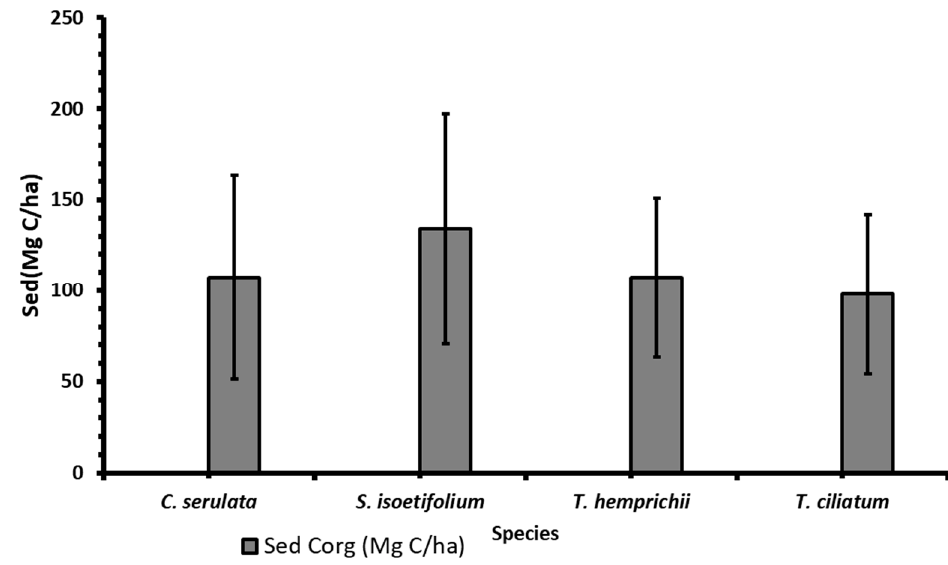
Figure 4. Corg stock in top 50 cm in sediments of dominant seagrass species in subtidal area.